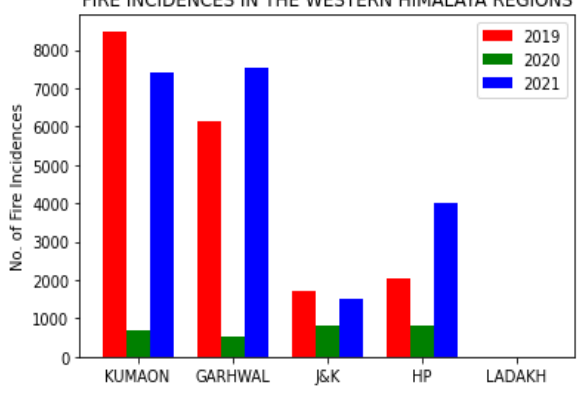
Figure 3. Number of fire incidences in the five regions of